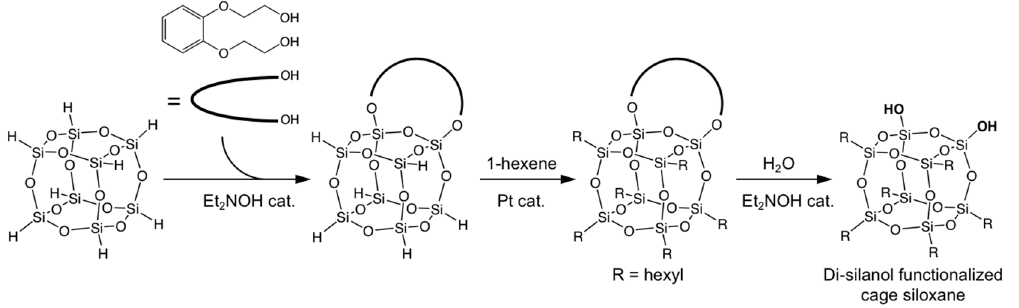
Figure 6. Synthesis of di-silanol functionalized cage siloxanes using a di-hydroxy organic compound. Molecules 2020 , 25 , 524